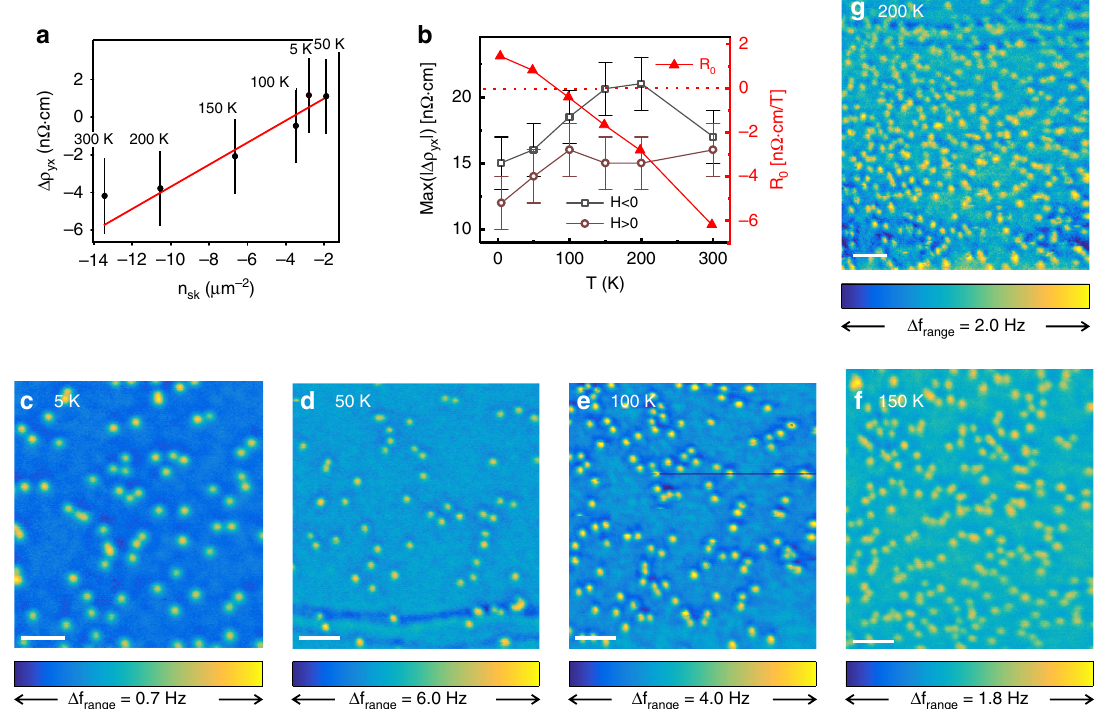
Fig. 2 Temperature dependence of n sk , Δ ρ yx , and R 0 . The sign of n sk is chosen to match Δ ρ yx . a Δ ρ yx as a function of n sk for different temperatures at μ 0 H = − 0.3 T . Labels show the measurement temperature. Error-bars for Δ ρ n yx represent a conservative estimate of the systematic error. Errors for sk are smaller than the symbols. The line is a linear fi t (slope 0.6 ± 0.1 n Ω · cm/ μ m − 2 , intercept 2.2 ± 0.8 n Ω · cm). b Left axis: magnitude of the THE peaks ( H < 0 — squares, H > 0 — circles). Right axis: the fi t parameter R 0 ( T ) from Eq. (3) (triangles). c – g MFM scans showing isolated skyrmions for n sk ( T ) in a . [For c – g scan-height h = 75, 40, 40, 100, 40 nm, ( c ) is Fig. 1b, scale bars are 1 μ